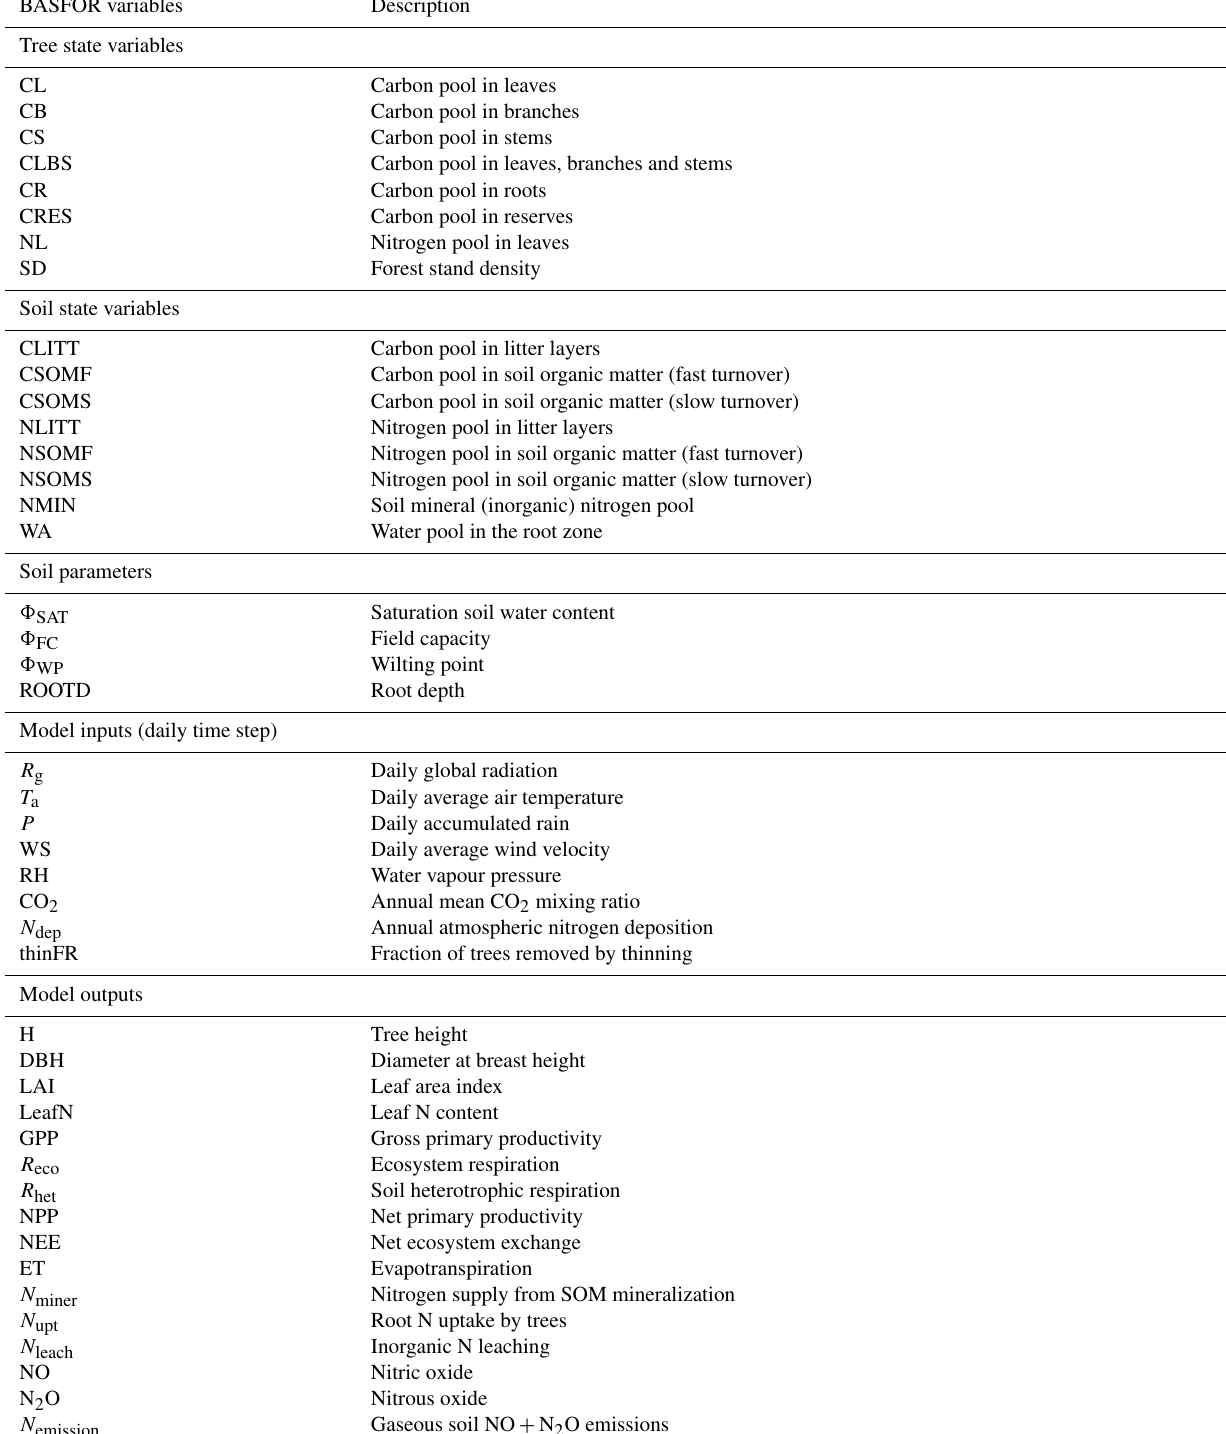
Table 1. BASFOR model state variables, inputs and outputs, and other acronyms used in the study. BASFOR variables